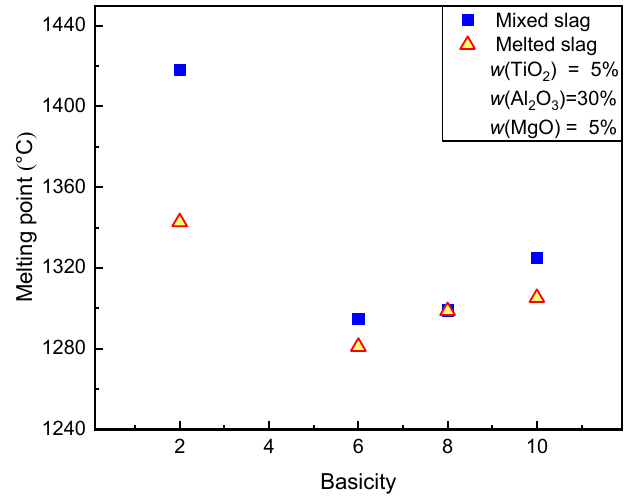
Figure 4. Effect of slag basicity on the melting points of slags.